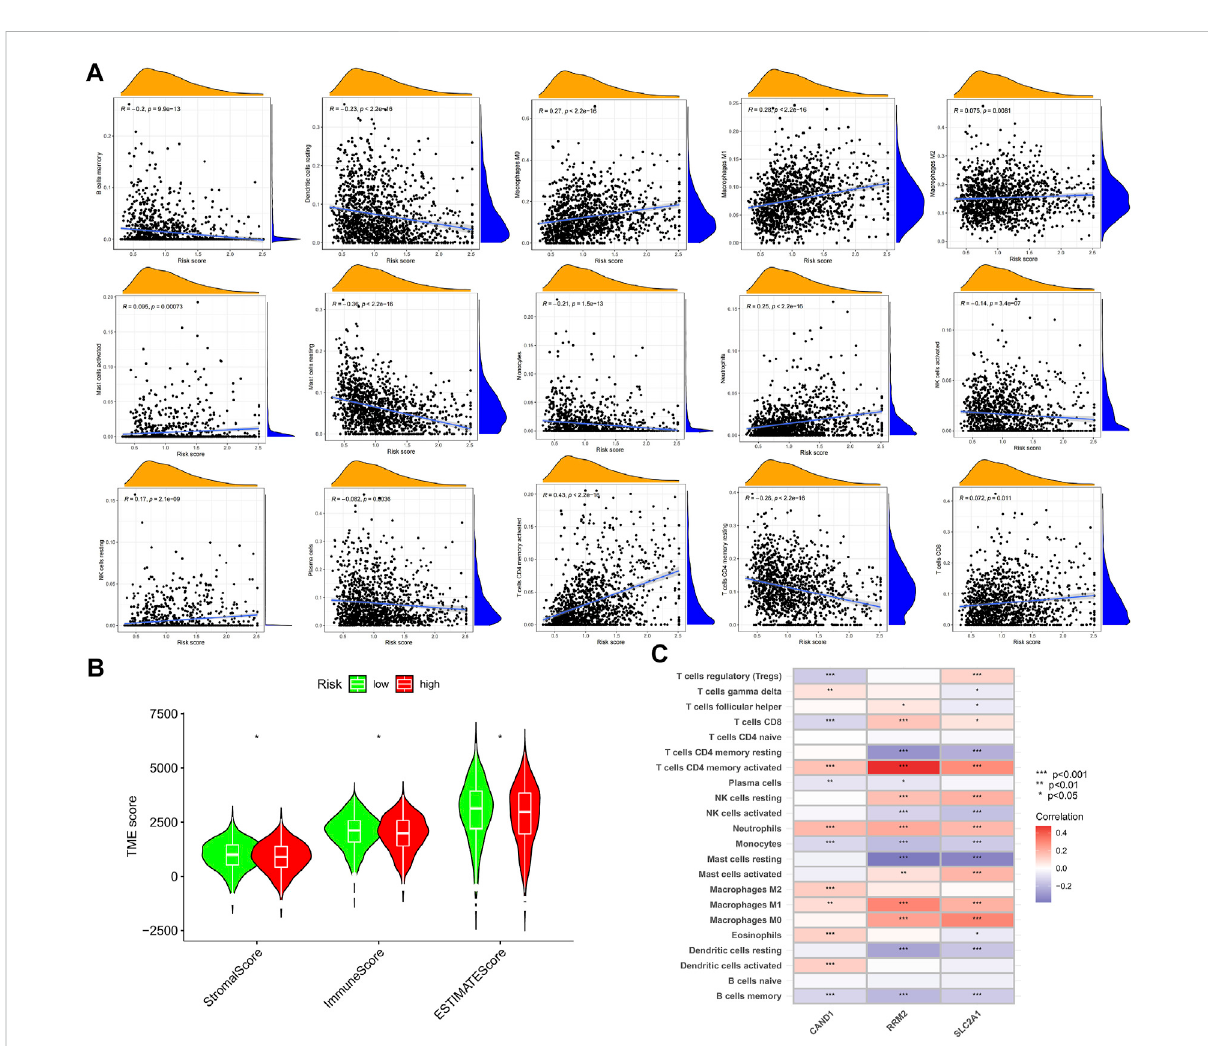
FIGURE 9 TMEof thehigh- and low-risk groups. (A) Association of them7G-Riskscore with immunein fi ltrates. (B) Association of them7G-Riskscore with immune, stromal, and ESTIMATE scores. (C) Association of the three signature genes (CAND1, RRM2, and SLC2A1) with immune in fi